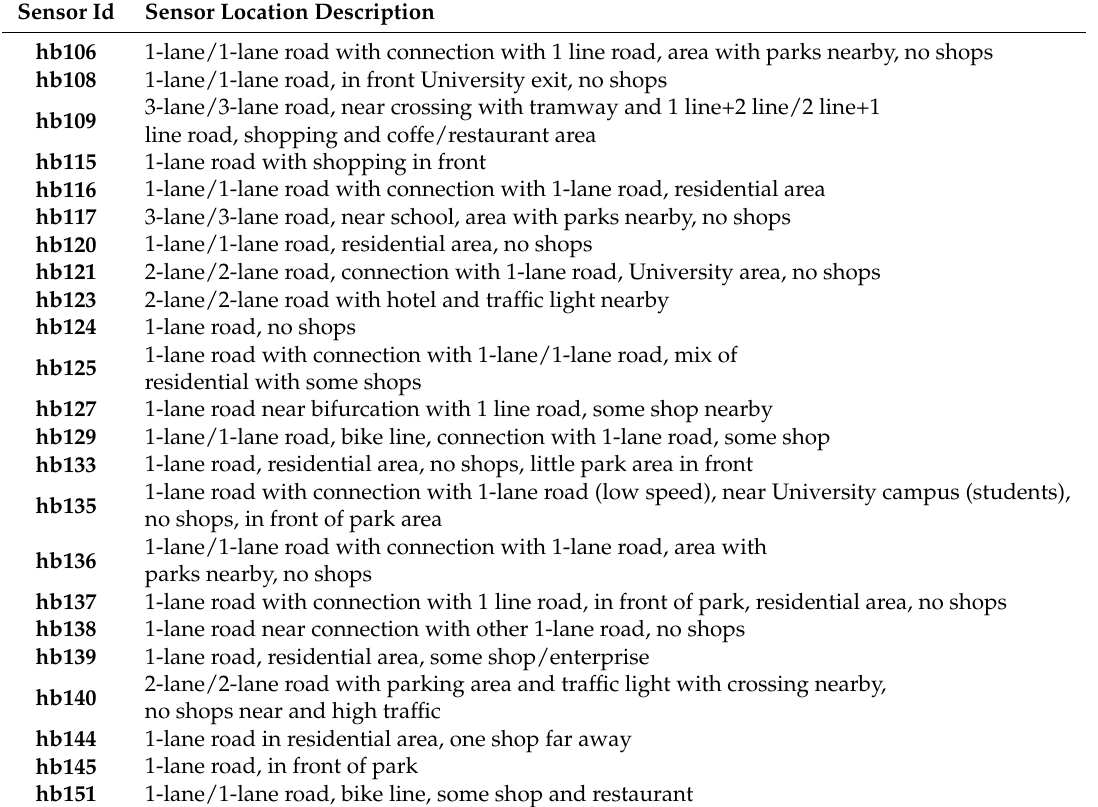
Table A1. Sensor locations description for the urban environment. X-lane/Y-lane road stands for a two-way road that has X lanes in one sense and Y lanes in the opposite sense. X-lane road stands for a street with X lanes in the same sense.